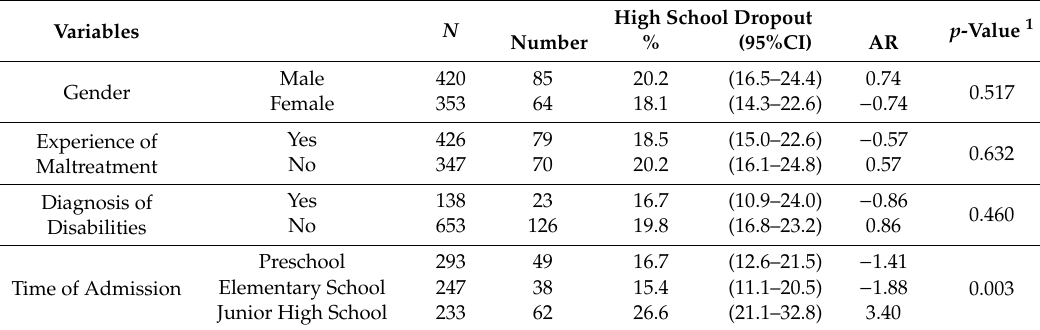
Table 2. High school dropout rate by related